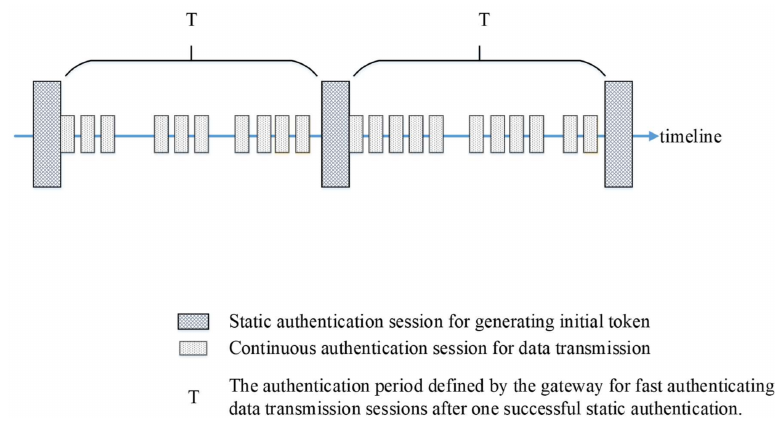
Figure 2. The proposed authentication protocol framework through